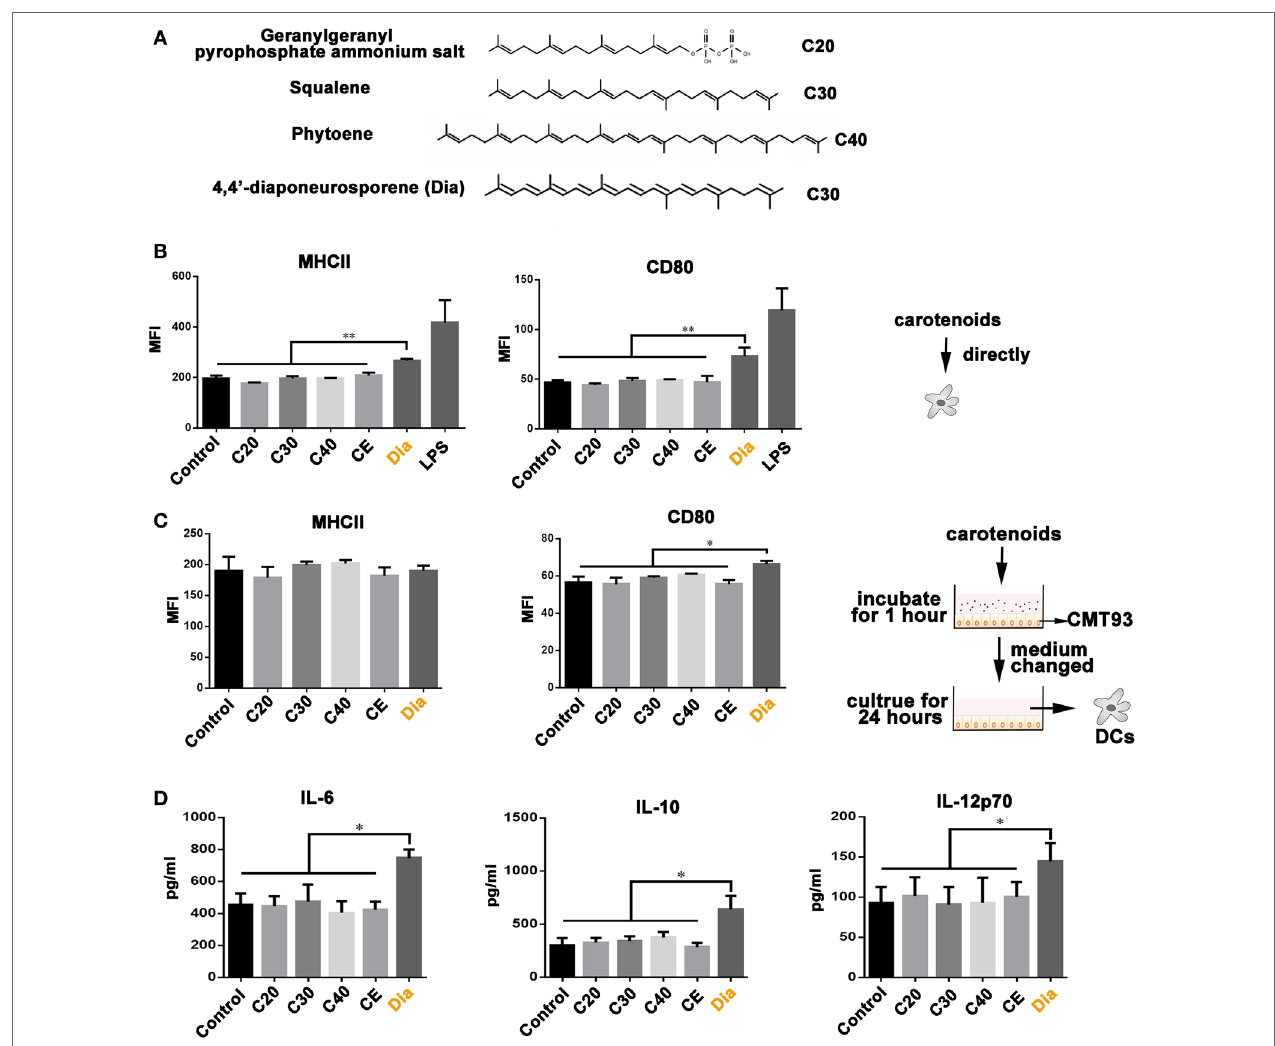
FigUre 1 | The unique function of 4,4 ′ -diaponeurosporene (Dia) on dendritic cells (Dcs) . (a) The structural representation of geranylgeranyl pyrophosphate ammonium salt, squalene, and phytoene. (B) DCs were treated with 1µM indicated carotenoids for 24 h, and the expression of MHCII and CD80 were analyzed by flow cytometry. CE: extraction from Bacillus subtilis harboring pMK3. (c,D) CMT93 cells were treated with different carotenoids for 1 h, and the medium containing carotenoids were removed. After washing three times, fresh medium was added and cultured for 24 h. Then, the mediums were collected to incubate DCs. After 24 h, the expression of MHCII and CD80 on DCs were analyzed by flow cytometry (c) , and the levels of IL-6, IL-10, and IL-12p70 in supernatants were detected by ELISA (D) . One representative of three similar independent experiments is shown. Asterisks indicate statistical significance via the one-way ANOVA test (* P < 0.05, ** P <